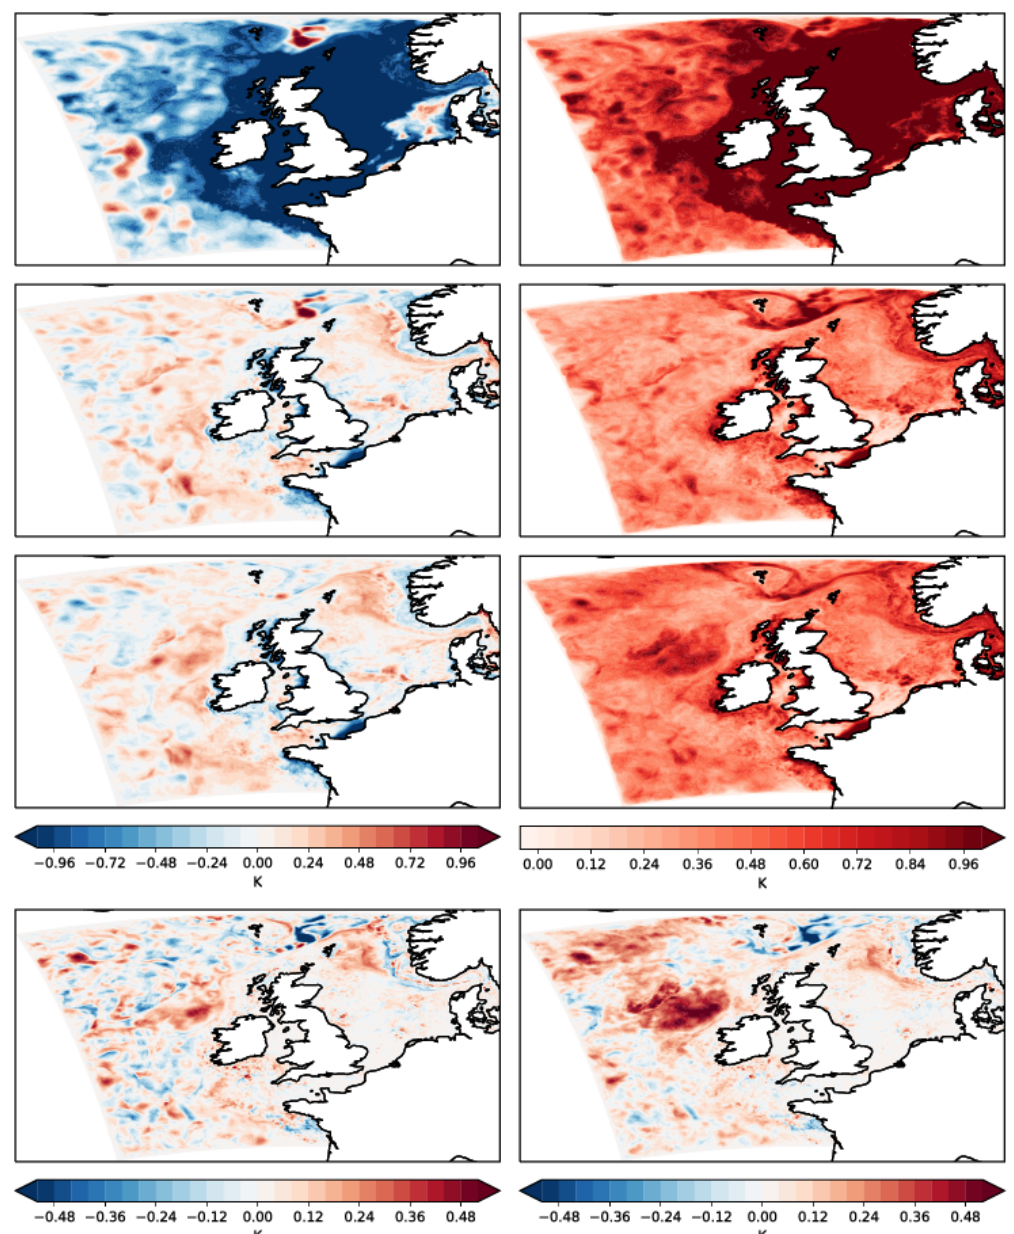
Figure 11. June 2018 vertically averaged temperature bias (left) and RMSE (right) for the free run (top), control (second row) and LowErr- SWOT experiments (third row). The difference (control – LowErrSWOT) in the absolute bias and RMSE between the control and LowErr- SWOT experiments is also shown (bottom row) to highlight the impact of the additional SWOT